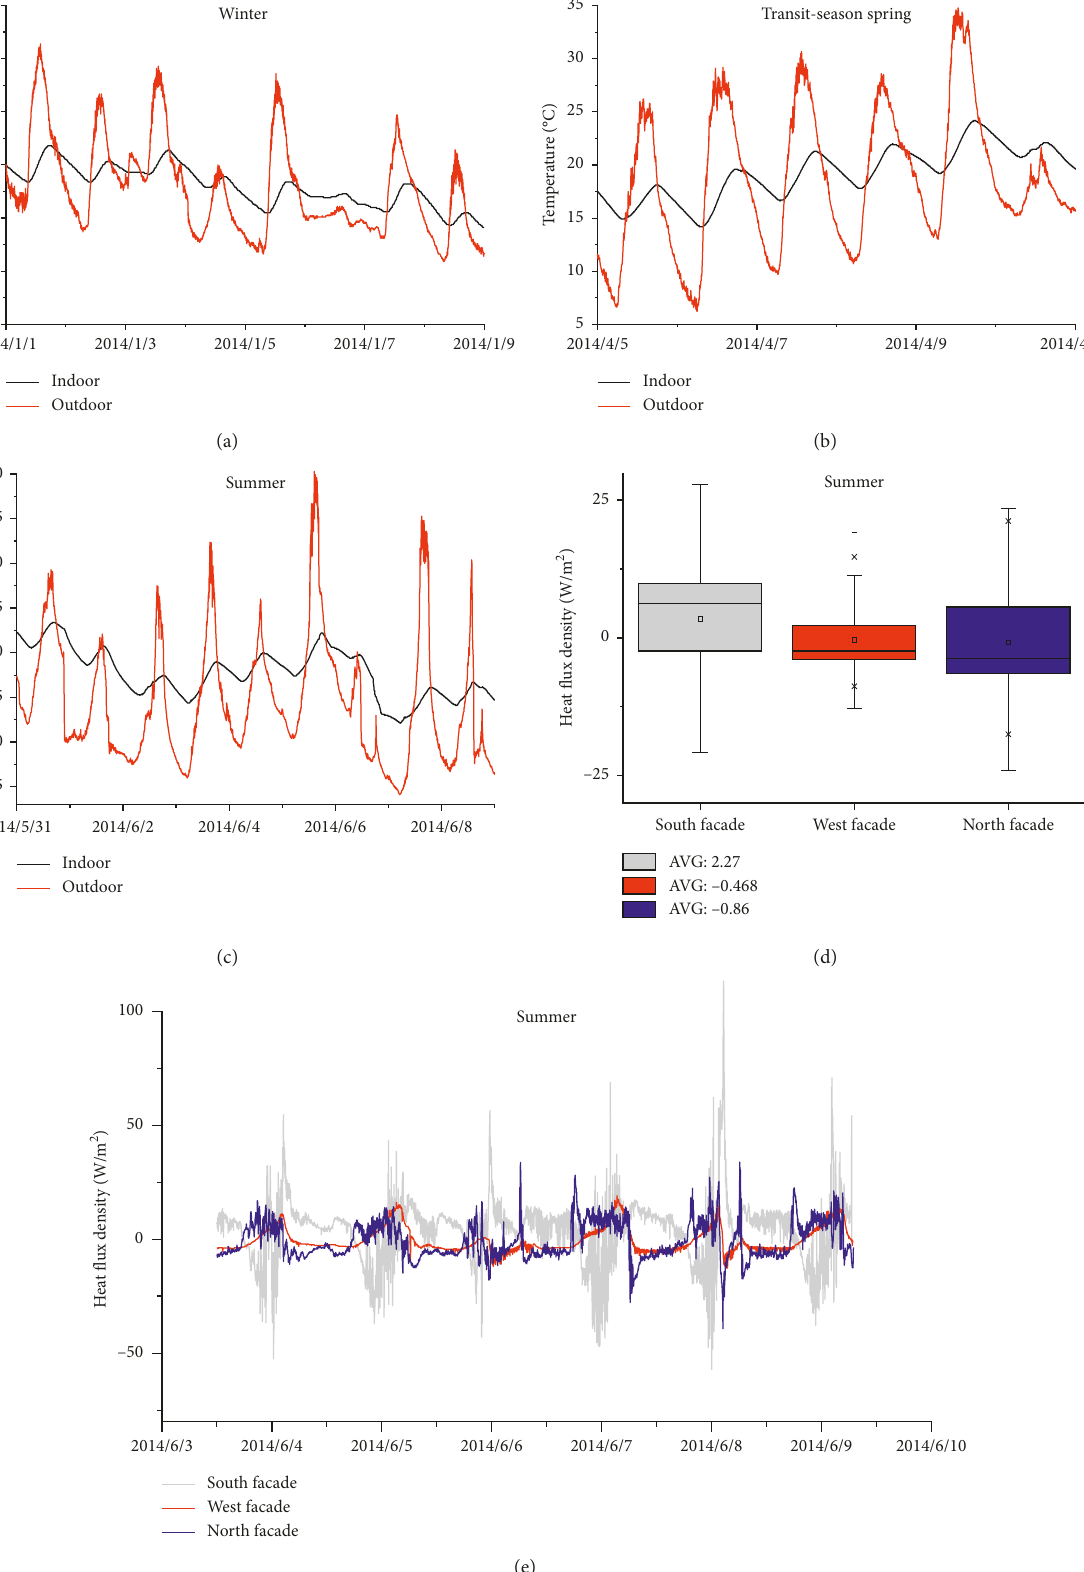
Figure 16: Thermal environment test of a modular prefabricated building using HIPs as the insulation material (source: authors’ own data). (a) Winter temperatures; (b) transitional season temperatures; (c) summer temperatures; (d) floating box line diagram of summer heat flux density; (e) hourly curve diagram of summer heat flux